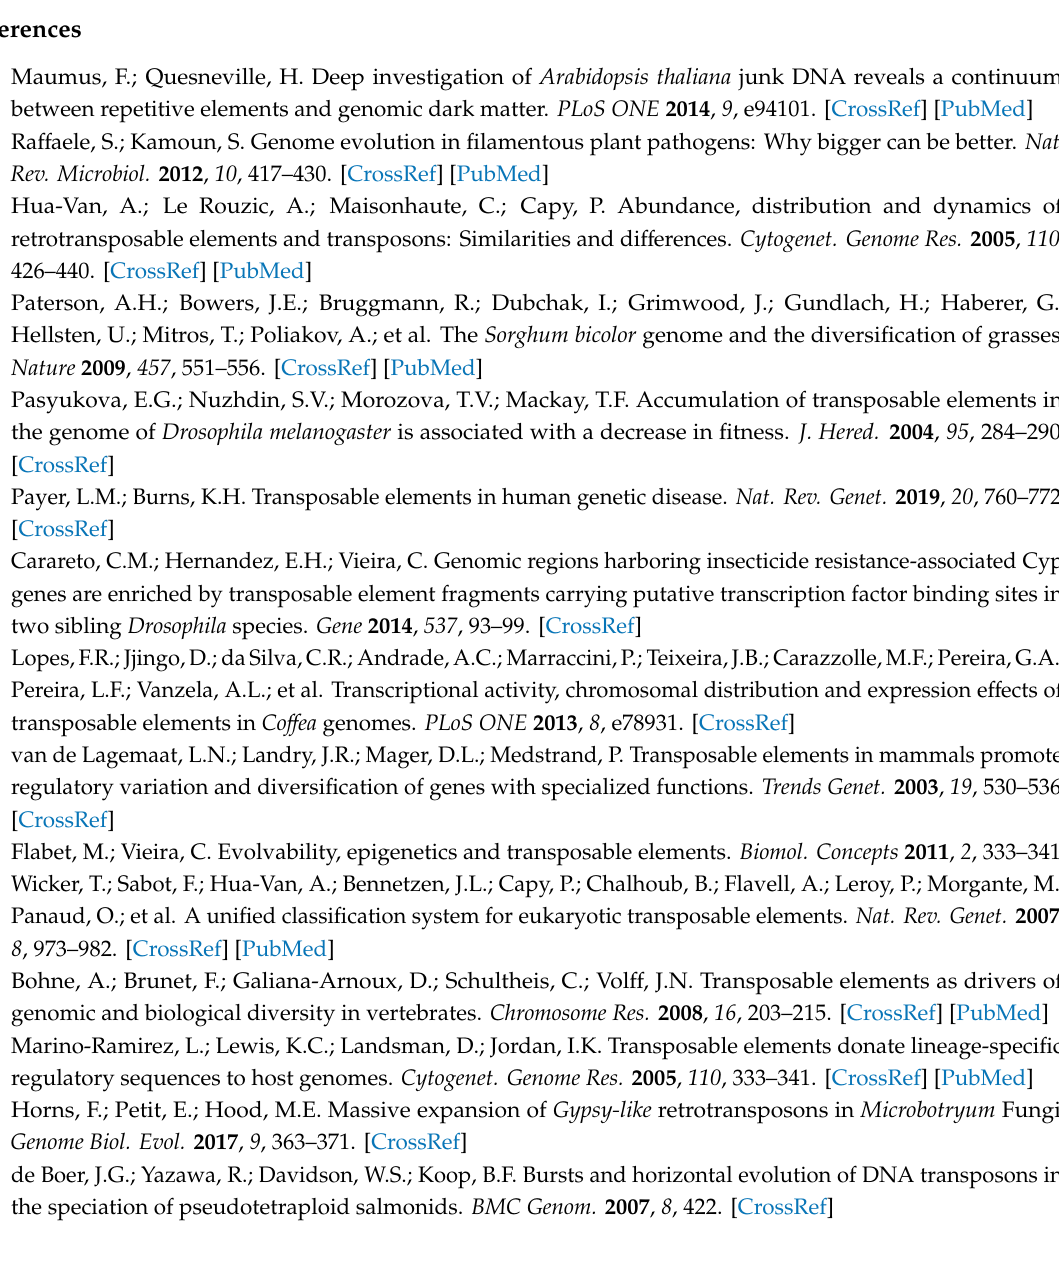
and comparison of shared TE family content, Figure S2: Scatter plot and analysis of linear regression of the relative genome proportions of shared TE families between the Rhodnius genomes in terms of genome